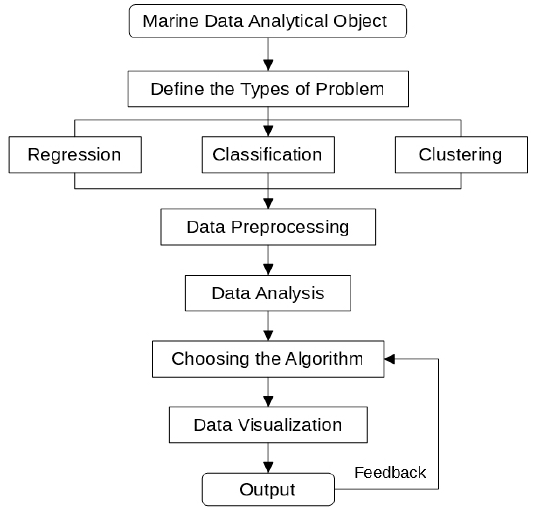
Figure 1. Marine data analytical process.